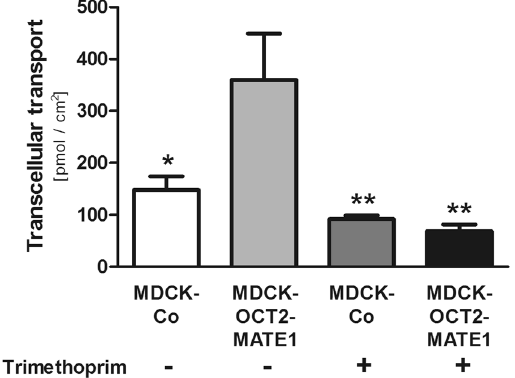
Figure 3. Transcellular transport of TMAO (10 µ M) across polarised grown monolayers of MDCK cells expressing both OCT2 and MATE1 (MDCK-OCT2-MATE1) and control cells (MDCK-Co) after 60 min without ( − ) or with ( + ) addition of trimethoprim (100 µ M) to the basal compartment. Each data point is 2 × n = 2, mean ± SEM, * p < 0.05 vs. MDCK-OCT2-MATE1 without trimethoprim, ** p < 0.01 vs. MDCK- OCT2-MATE1 without